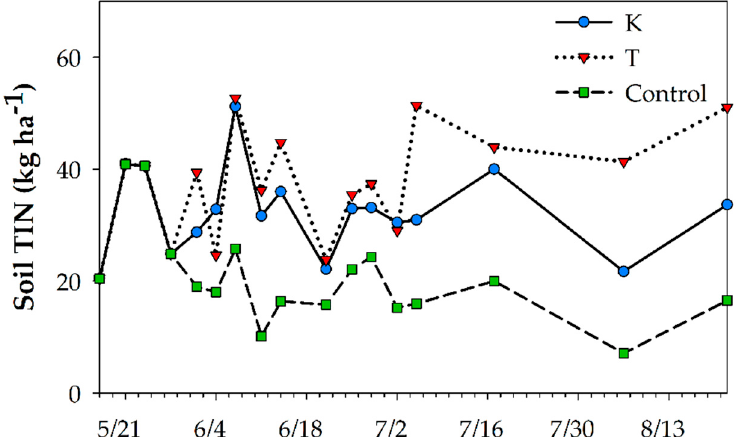
Figure A4. Soil TIN concentration over the entire sampling period as a function of banded herbicide (K) and zone tillage (T) row management and with unmanaged clover (Control).